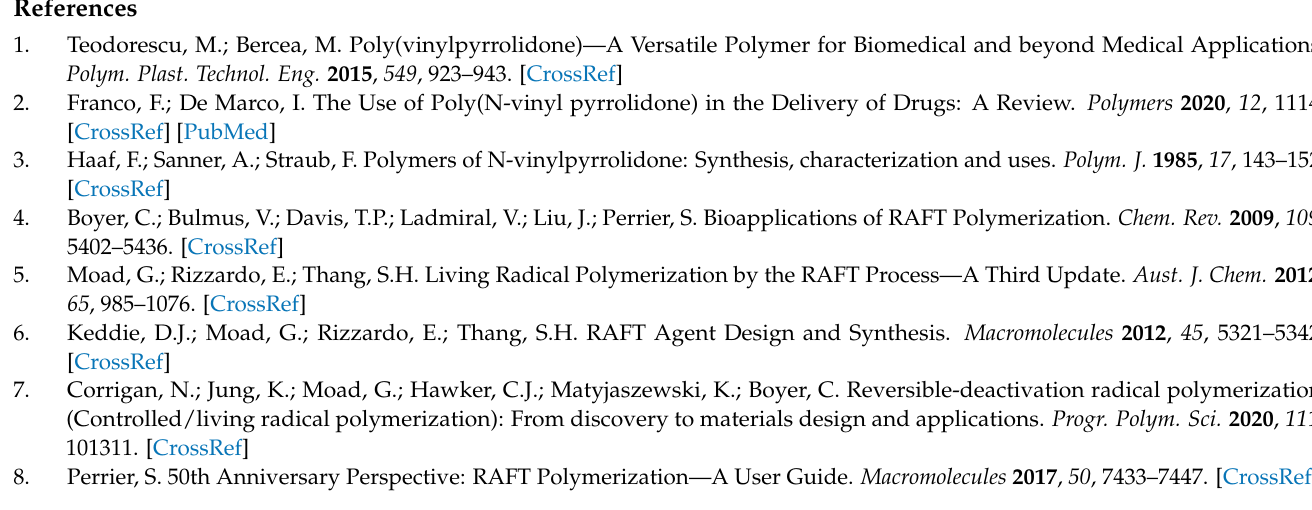
Figure S18. Weight loss with temperature under different heating rates for the P(NVP–stat–CEVE) 80/20. Figure S19. Derivative weight loss with temperature under different heating rates for the P(NVP–stat–CEVE) 80/20. Figure S20. (OFW) plots for the sample P(NVP–stat–CEVE) 80/20. Figure S21. (KAS) plots for the sample P(NVP–stat–CEVE)